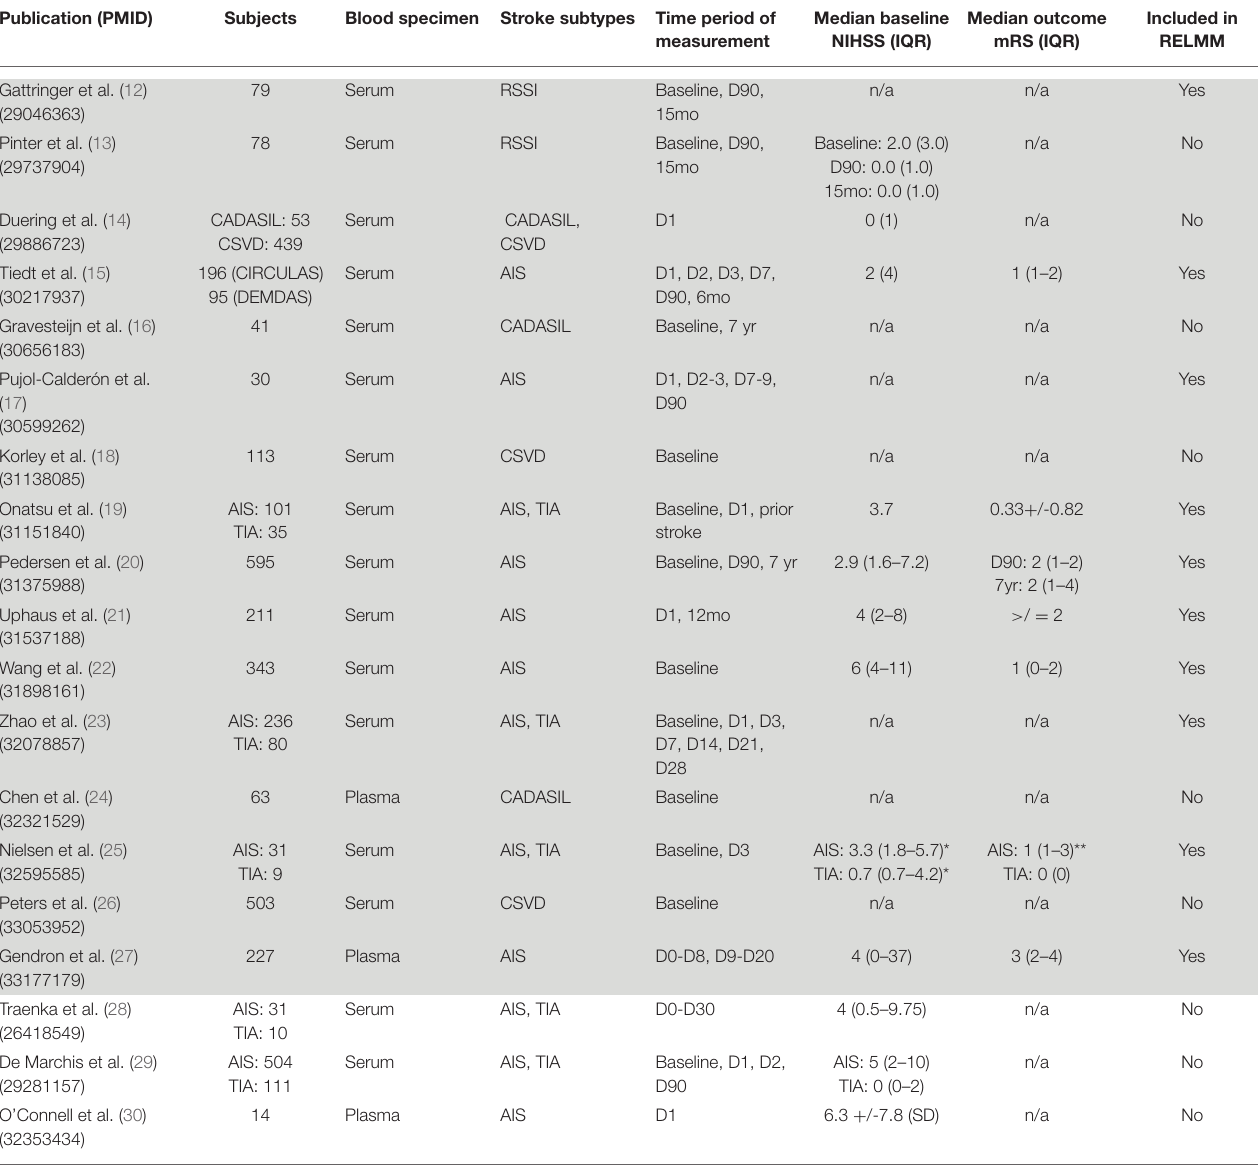
TABLE 1 | Articles included in meta-analysis of blood NfL as stroke and cerebrovascular disease biomarker. Publication (PMID) Subjects Blood specimen Stroke subtypes Time period of